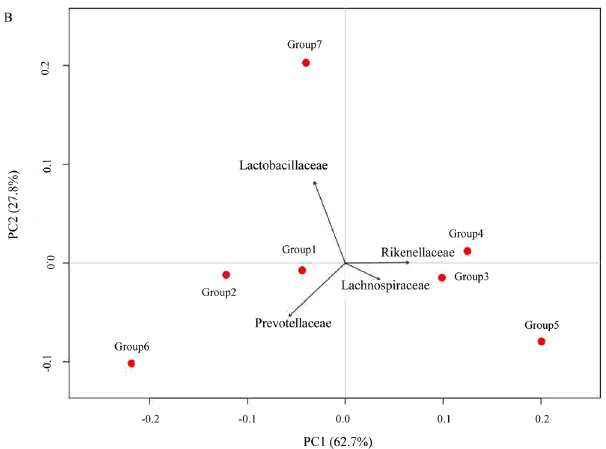
Figure 4. The Principal Component Analysis (PCA) of caecal samples in chickens supplemented with different probiotic additives (Group 1 to Group 6) and chicken without probiotic addition (Group